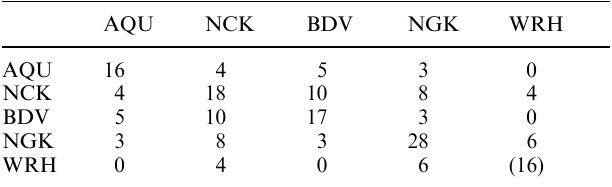
Table 2. Common spectral lines at station